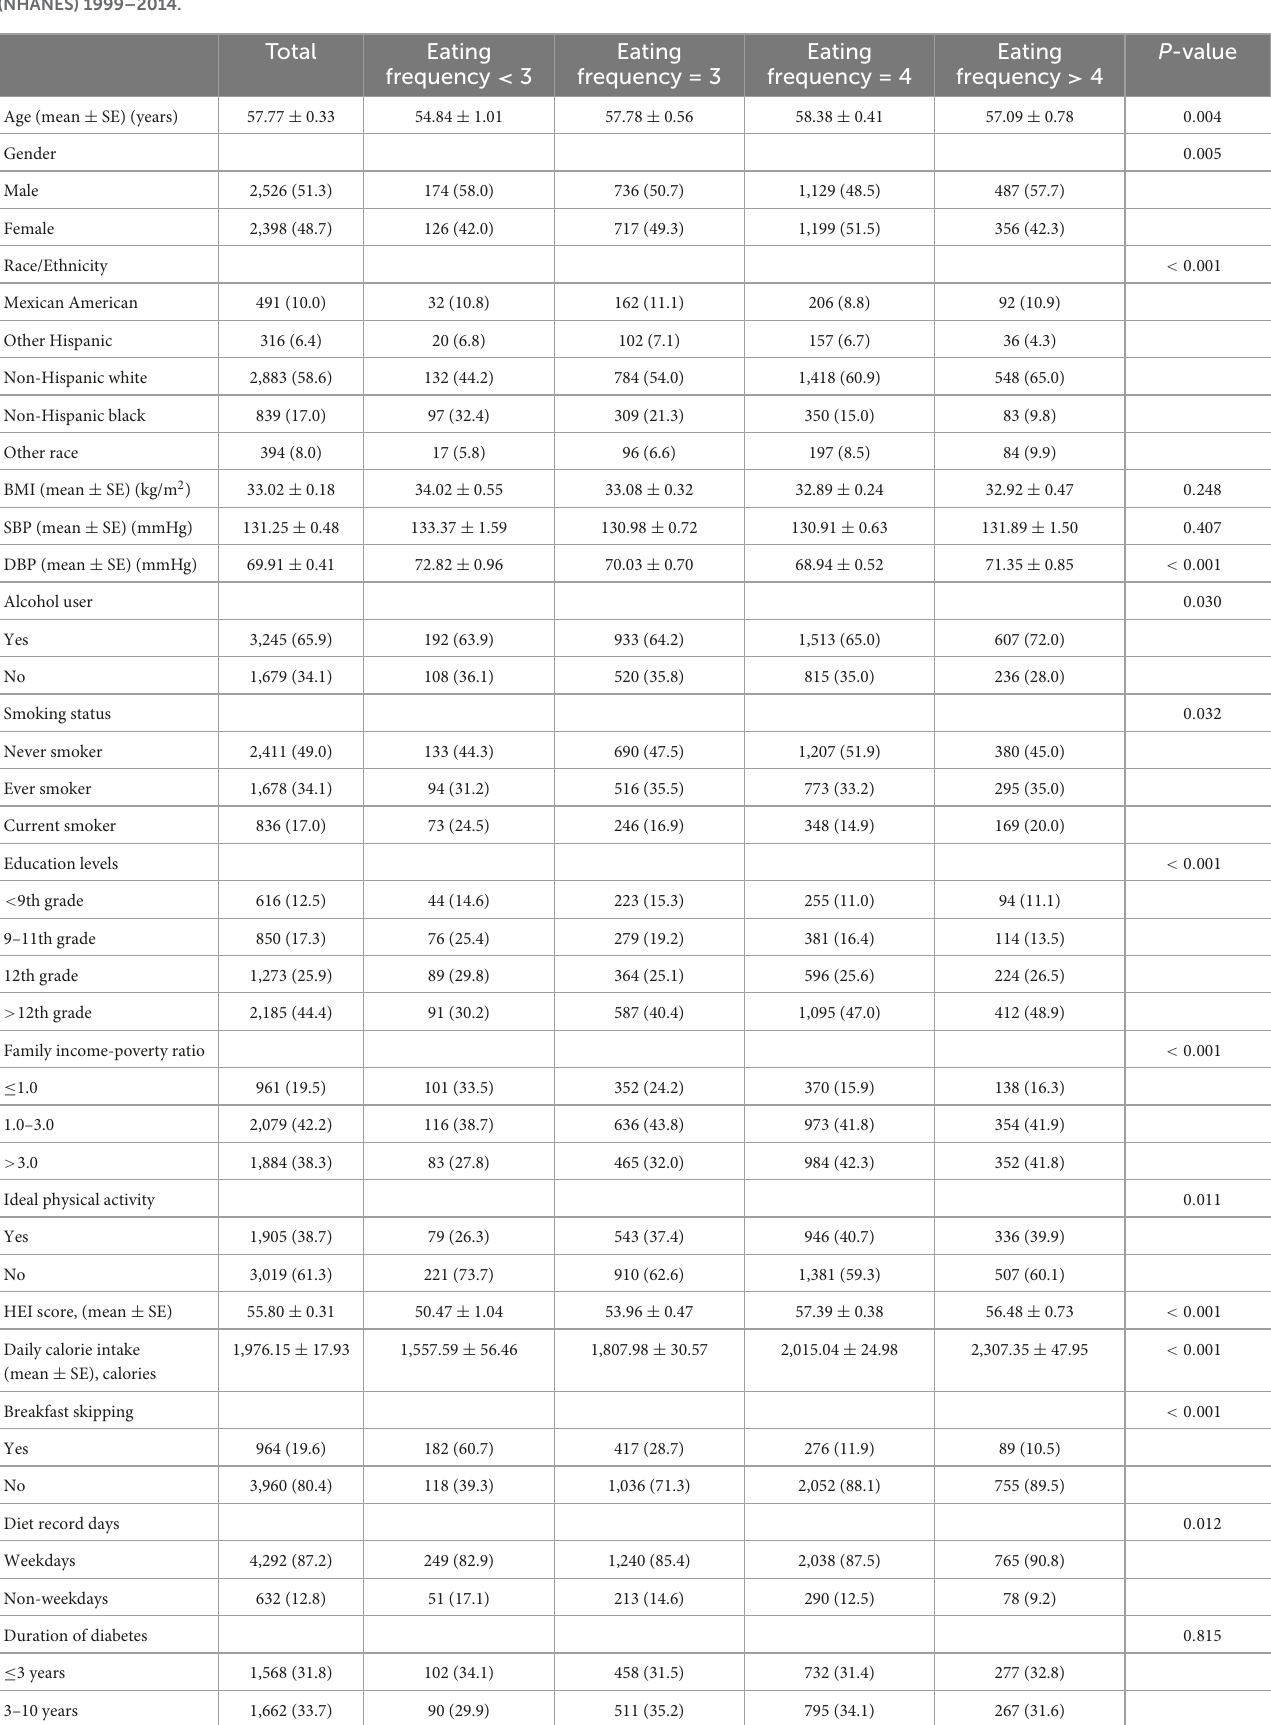
TABLE 1 Baseline characteristics of participants with diabetes classified according to eating frequency in National Health and Nutrition Examination Survey (NHANES) 1999–2014.